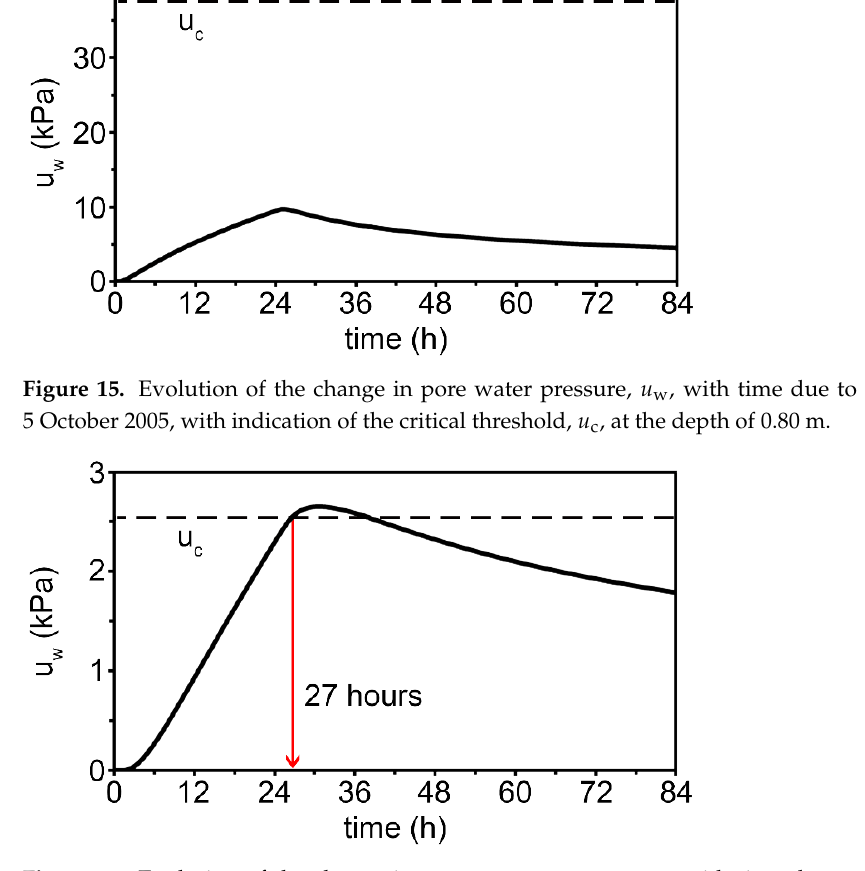
Figure 16. Evolution of the change in pore water pressure, w u , with time due to the rainfall of 1 May 2006, with indication of the critical threshold, c u , at the depth of 0.80 m.